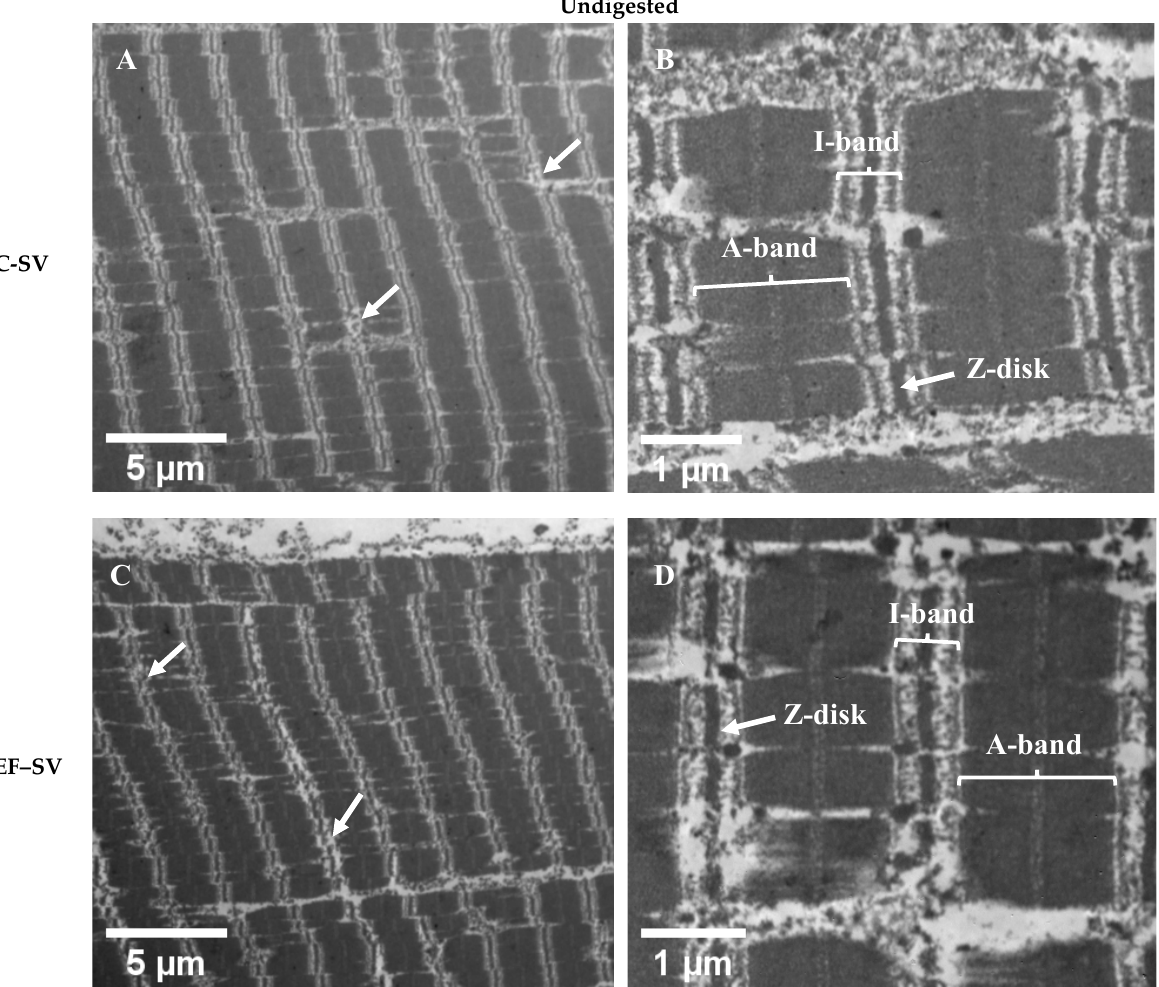
Figure 4. Transmission electron micrographs showing the ultrastructure of the control ( C ) sous vide (SV)-cooked ( A , B ) and the PEF-treated SV-cooked ( C , D ) beef brisket before simulated oral–gastro–small intestinal digestion.